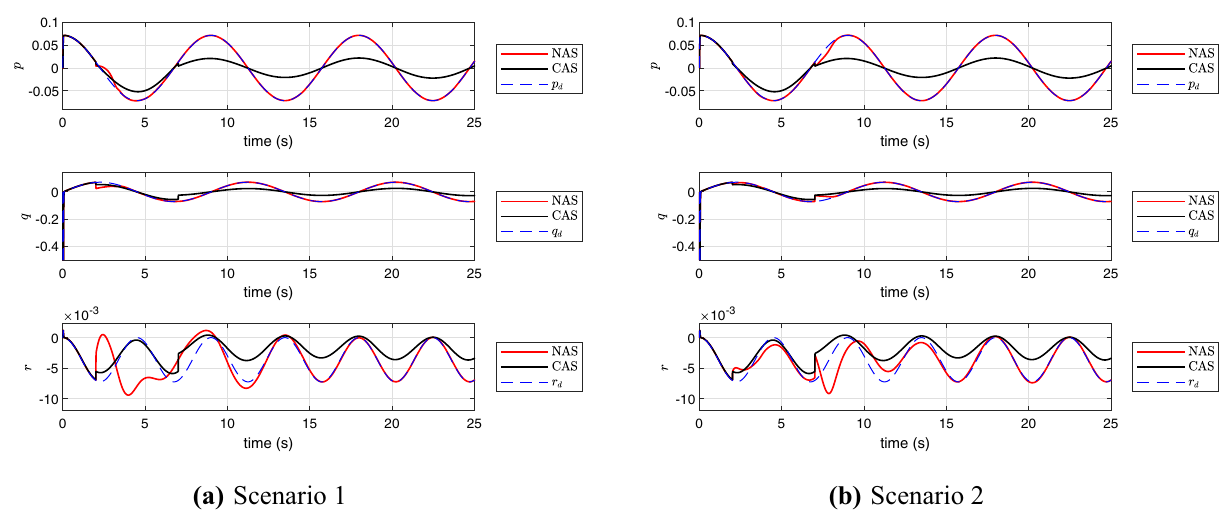
Figure 11. The profile of p , q and r in the presence of abrupt